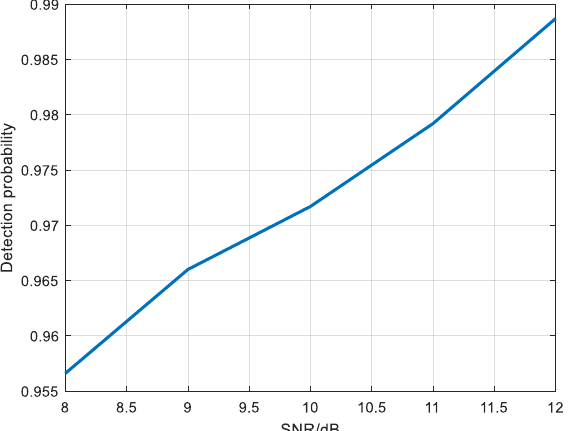
Figure 22. Partial 20 × 20 sample graph with target under the condition of 12 dB SNR.